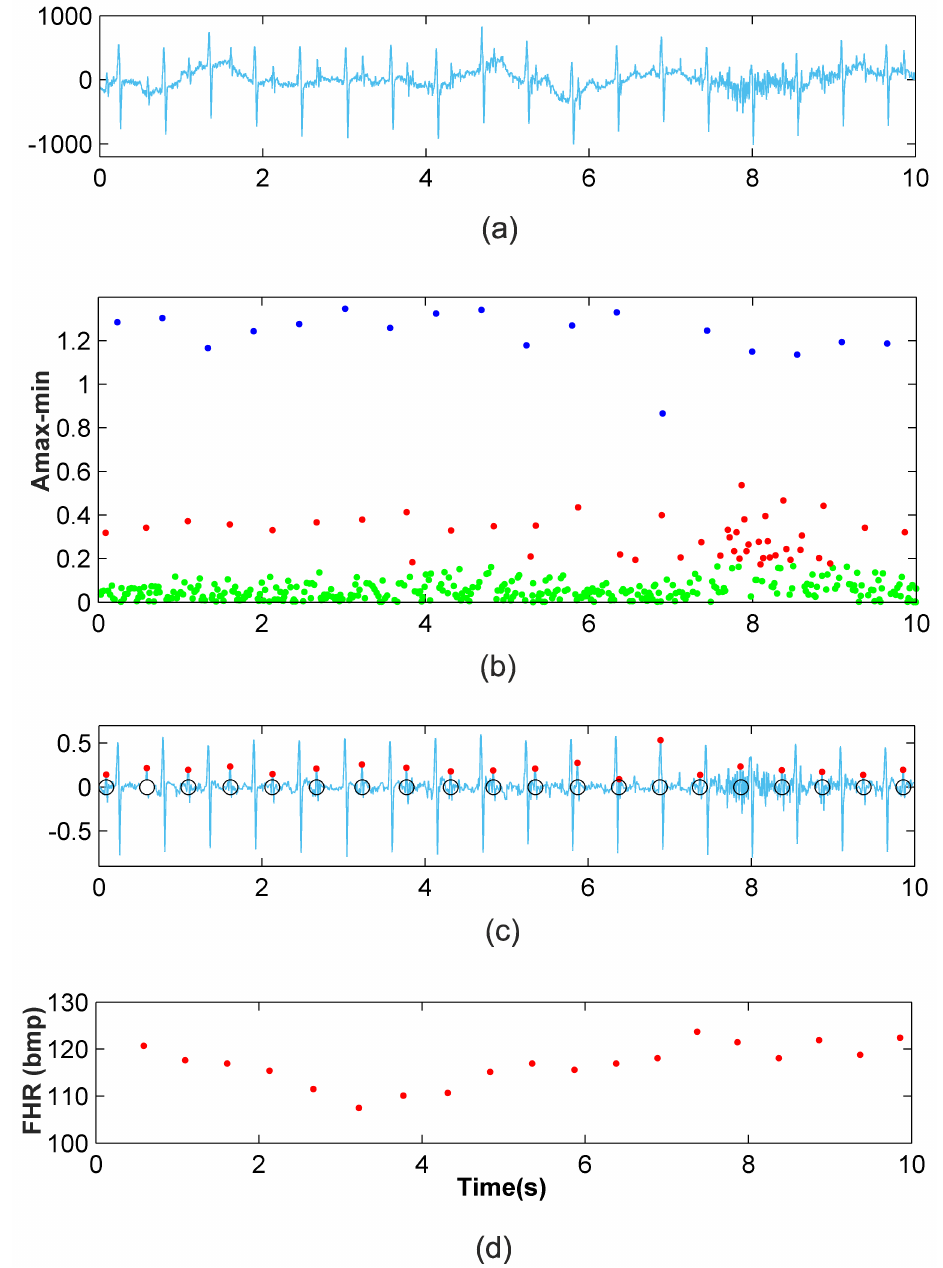
Fig 9. Application of the new method to the a03 Ab-4 recording. (a) 10-second recording (b) Clustering classification (c) Fetal RS detection after classification improvement and FP and FN correction (d) Ten-second FHR